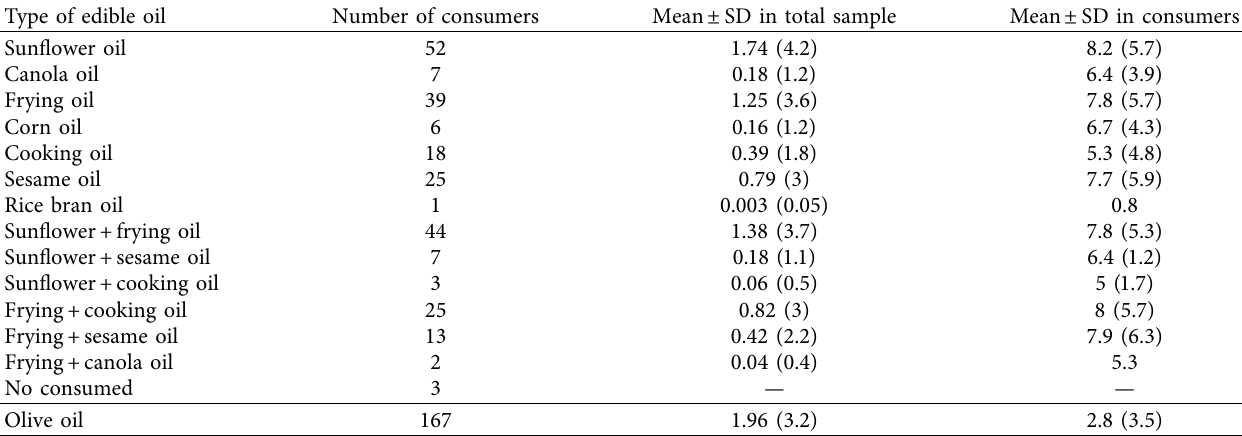
Table 1: Intake of vegetable liquid oils in participants